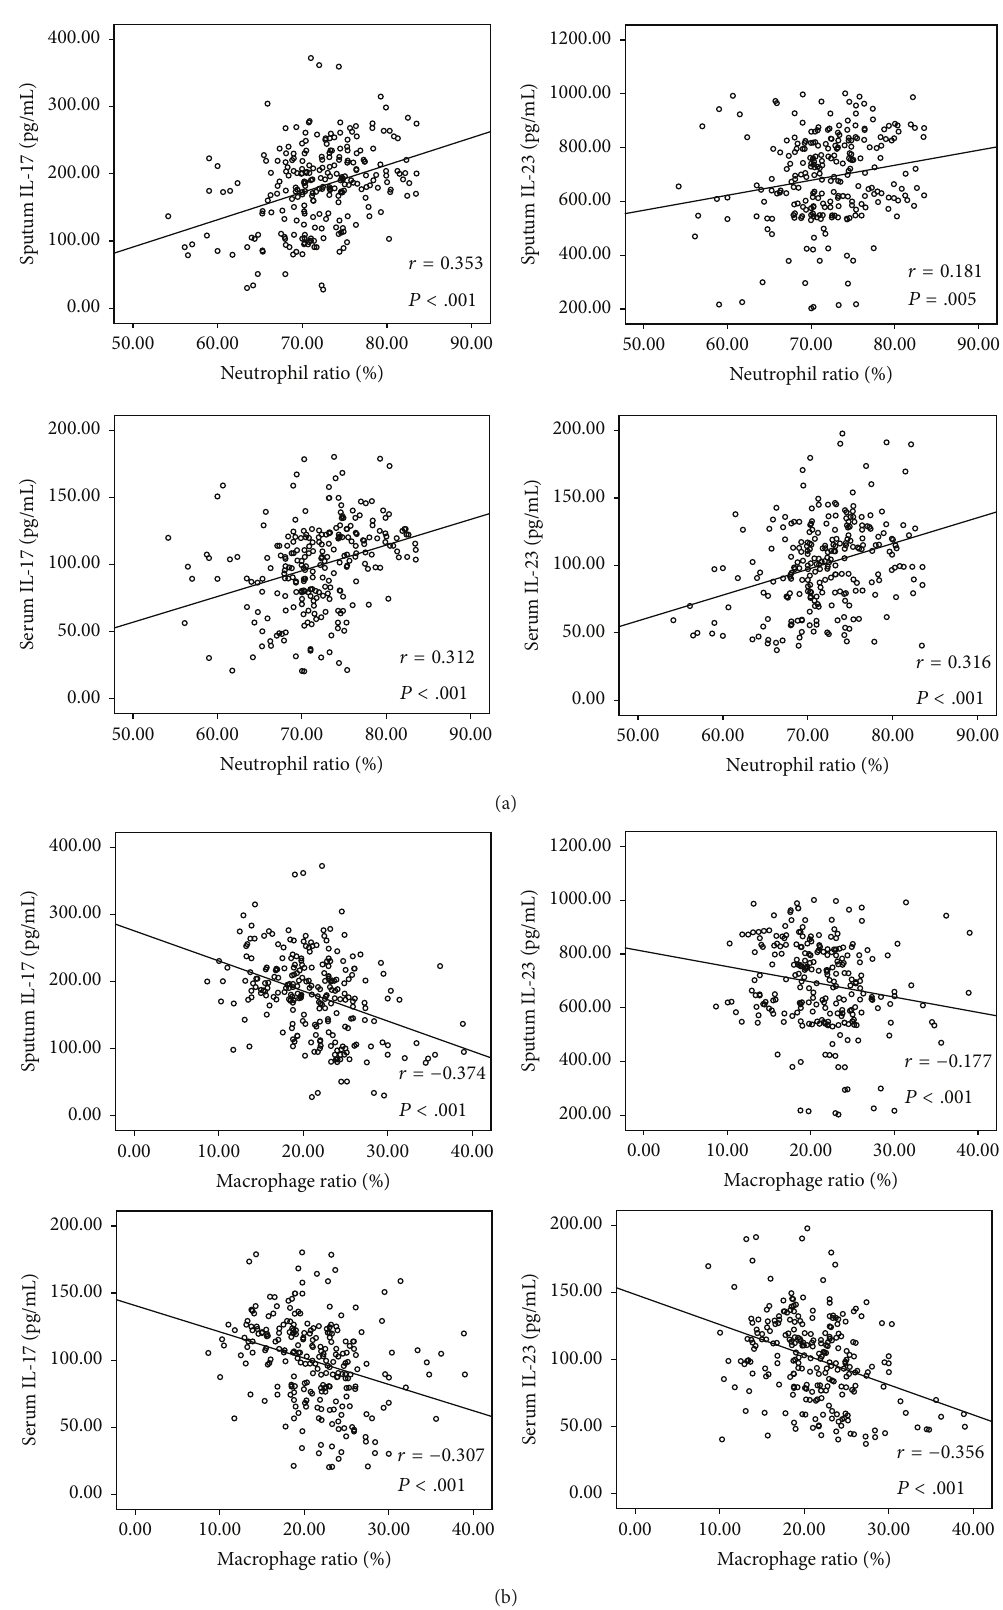
Figure 5: (a) Correlation between inflammatory cytokines including IL-17 and IL-23 in both sputum and serum and sputum neutrophil ratios. (b) Correlation between inflammatory cytokines including IL-17 and IL-23 in both sputum and serum and sputum macrophage